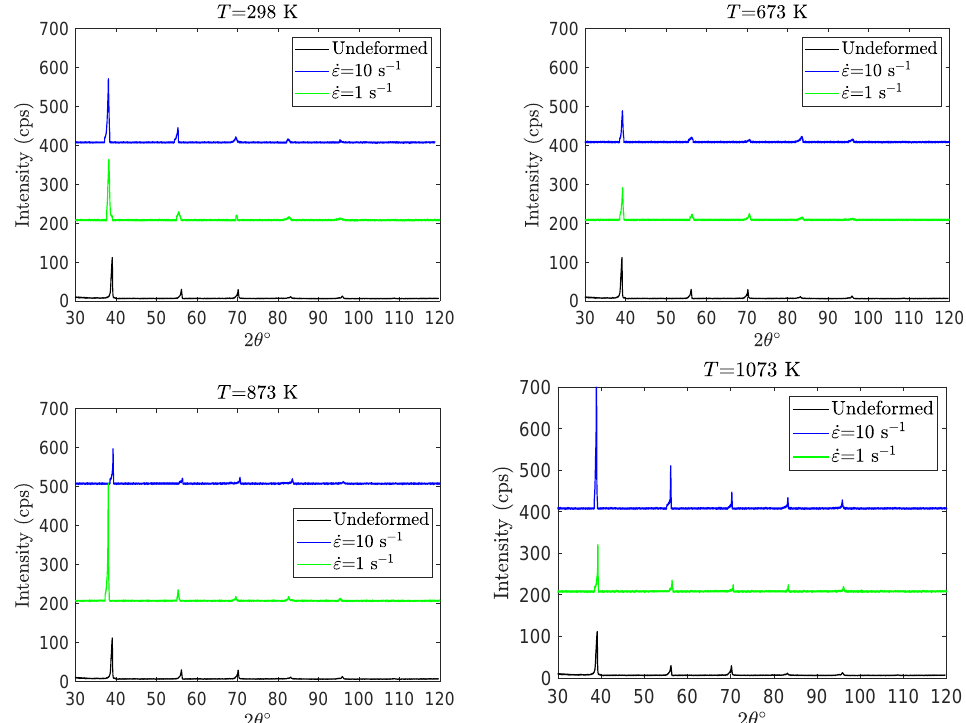
Figure 12. XRD patterns obtained with a Cu K α radiation for the compression tests carried out on Ti42Nb alloy produced with 90 ◦ building direction at temperatures ranging from 298 to 1073 K and two strain rates: 1 s − 1 and 10 s − 1 .